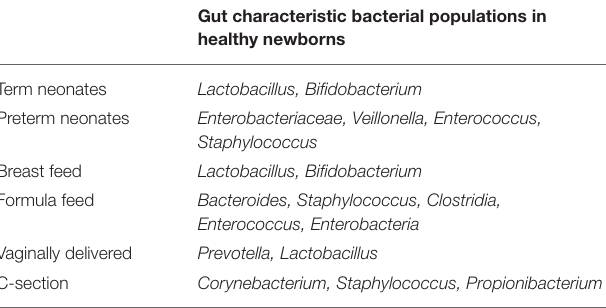
TABLE 1 | Summary of different categories of typical gut microbial pattern that can be found in healthy newborns. Gut characteristic bacterial populations in healthy